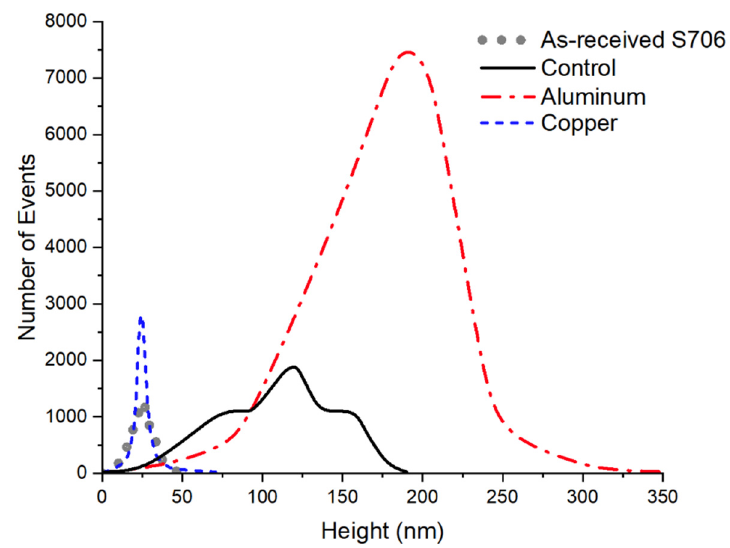
Figure 16. Comparison of surface profile height distribution.